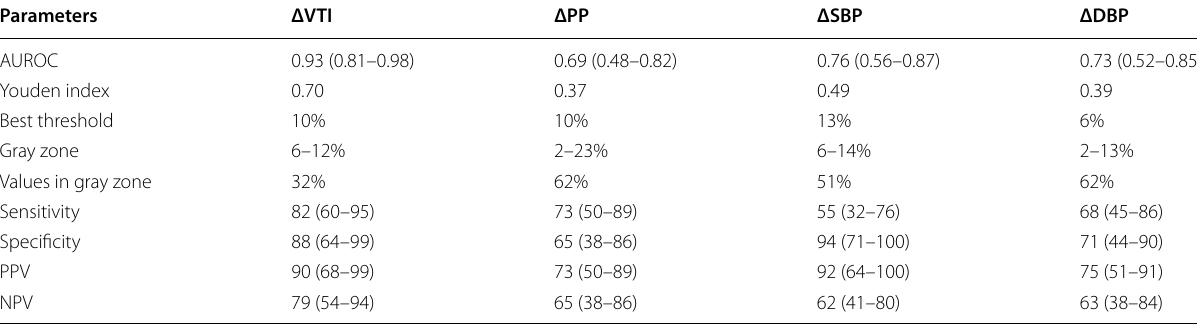
Values are median true value (95% confidence interval). Best threshold value was determined using the Youden index The AUROC of ΔVTI was higher than ΔPP ( p ΔDBP (ΔPP vs. ΔSBP, p